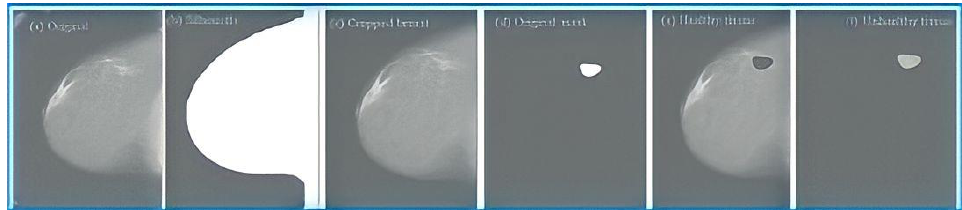
Figure 3. Images obtained during the training of the training set .